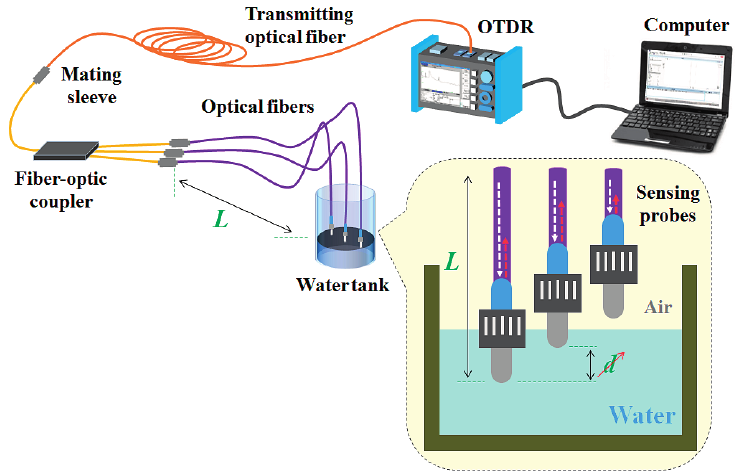
Figure 7. Experimental setup employed for the simultaneous measurement of temperature and water level using the fiber-optic water level